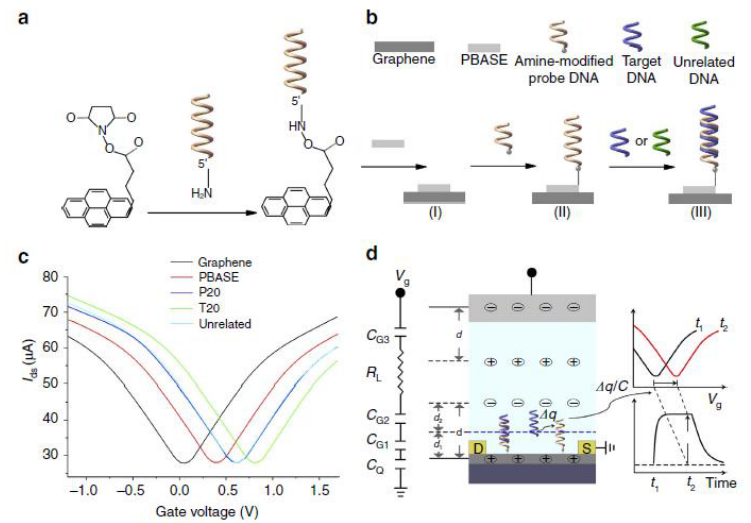
Figure 9. Characteristics of G-FETs. ( a ) The relationship between PBASE’s molecular structure and the probe DNA. ( b ) PBASE is used to functionalize the graphene surface. A probe DNA (shown in orange) is immobilized by interacting with the PBASE. The probe DNA is then hybridized with the target DNA (shown in blue) and unrelated control DNAs (in green). ( c ) Graphs of the source drain current versus the constant source drain voltage (0.1 V) for different conditions of graphene. ( d ) A schematic showing the equivalent circuit made up of four parallel plate capacitors and a resistance (RL) linked in series and the sensing model of a G-FET. Reproduced from [97] (CC BY).